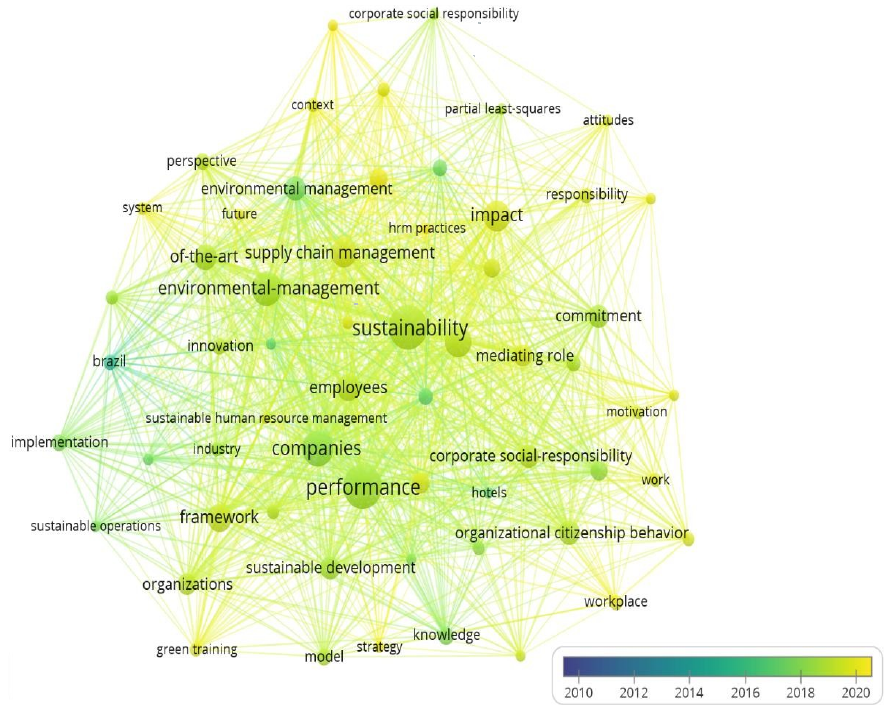
Figure 7. Keyword co-occurrence network with temporal